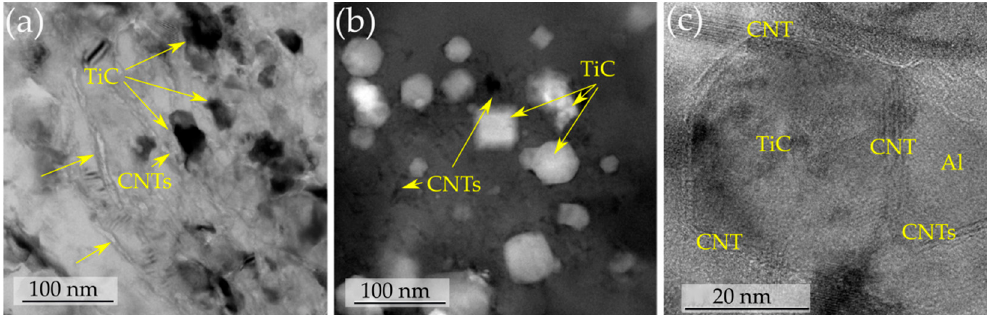
Figure 22. ( a ) Bright-field, ( b ) dark-field and ( c ) high-resolution TEM of Al/TiC/CNT composites [94]. Reproduced with permission from Kim et al., Scr. Mater. ; published by Elsevier, 2014.